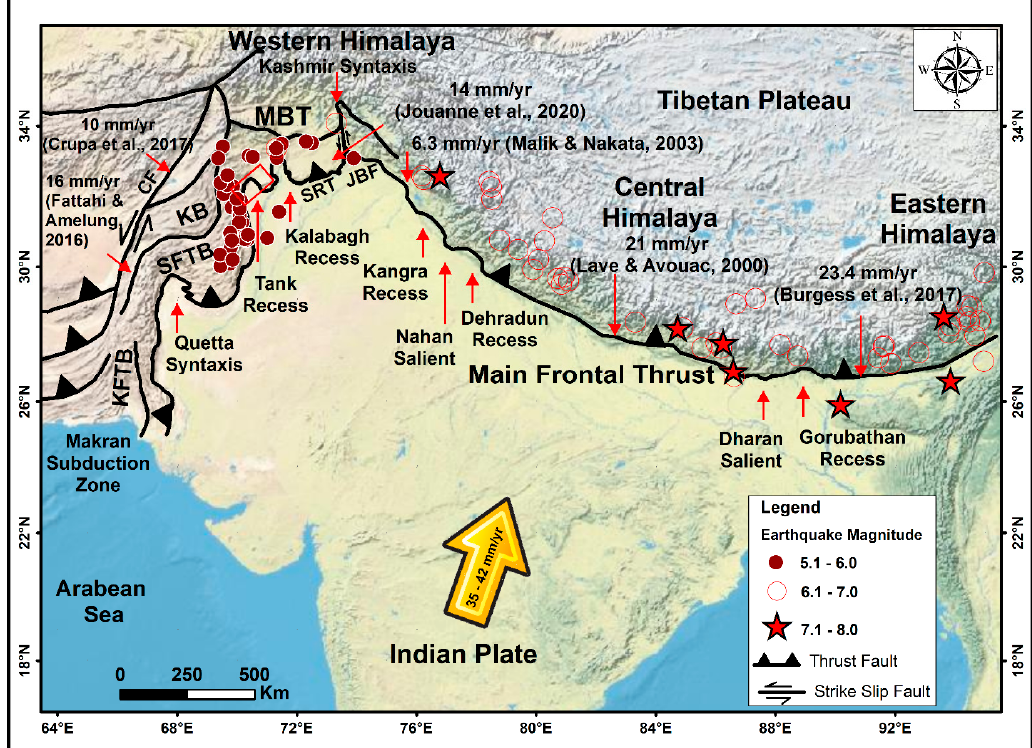
Figure 1. Satellite imagery showing the Himalayan arc and the southernmost youngest active thrust (MFT) with the associated historical earthquakes of a magnitude higher than seven (7) that had ruptured the surface. The across-strike structural variations are shown in the form of salient and recess. The calculated slip-rates along the MFT is also shown. The rectangular box indicates our study area in the Tank recess. Earthquake data were downloaded from the United States Geological Services (USGS). Faults were modified from Yin [1]. SRT: Salt Range Thrust, TIR: Trans Indus Ranges, KB: Katawaz Basin, WO: Waziristan Ophiolite, JBF: Jhelum Basement Fault, SFTB: Suleiman Fold–Thrust Belt, KFTB: Kirthar Fold–Thrust Belt.